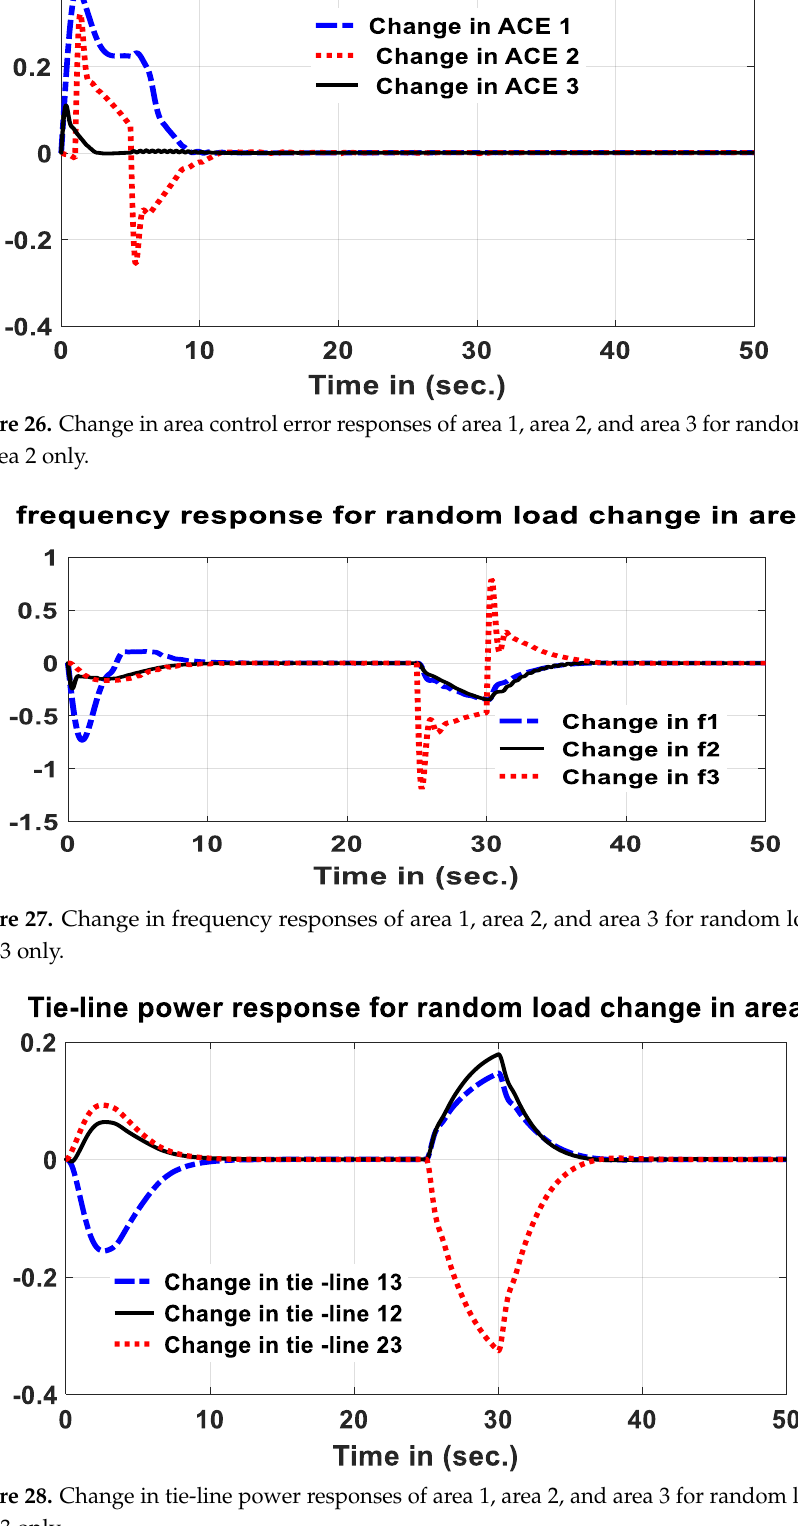
Figure 29. Change in ACE responses of area 1, area 2, and area 3 for random load change in area 3 only. 4. Discussion When random load change was applied to area 1, area 2, and area 3, based on the load change pattern of Figure 19, the frequency response also varied, i.e., when the load initially increases, the frequency decreases, and when the load suddenly drops, the fre- quency also increases, and vice versa.This frequency response is shown in Figure 20. 4.1. Case 1 Furthermore, to test the efficiency of the controller, three cases have been considered. In case 1, sudden load disturbance is created in area 1 from 0.01,0.02,0.03 p.u, and 0.4 p.u SLP for 20 s, keeping the remaining areas, area 2 and area 3, with an SLP of 0.2 p.u. Figure 21 shows that, when the step load disturbance increases from 0.01 p.u to 0.4 p.u for 20 s, f1 drops with a higher degree than f2 and f3. When the load suddenly drops to zero, the frequencies f1, f2, and f3 are increased; and as time goes on, all the frequencies settle after 26.58 s. Figure 22 shows that, when the step load disturbance increases from 0.01 p.u to 0.4 p.u for 20 s, the tie-line power p13 drops, while the other tie-lines in the remaining two